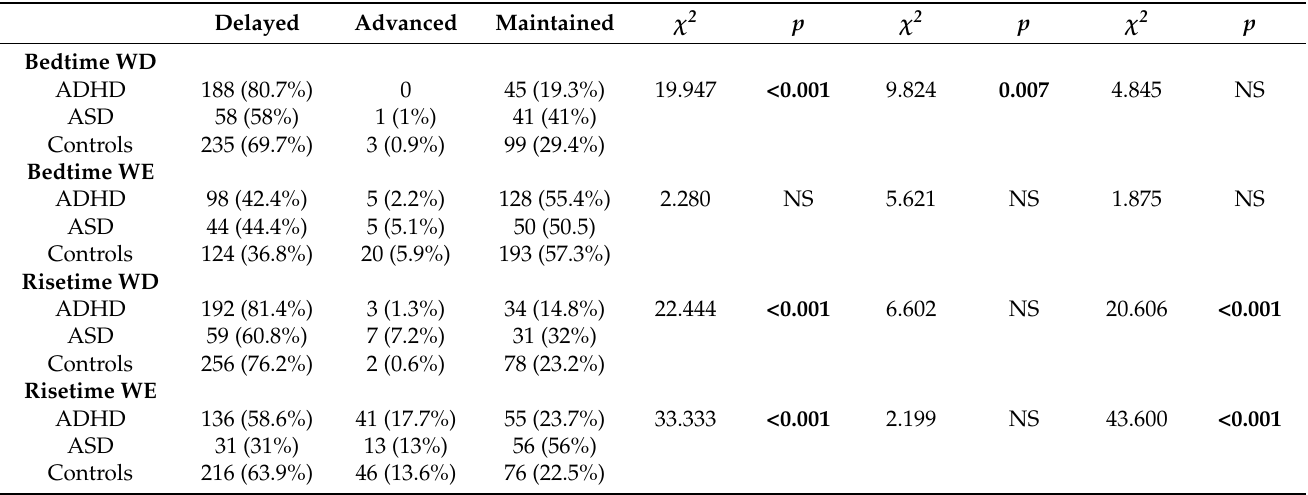
Table 5. Comparison of weekday–weekend bedtime and risetime in the three groups.